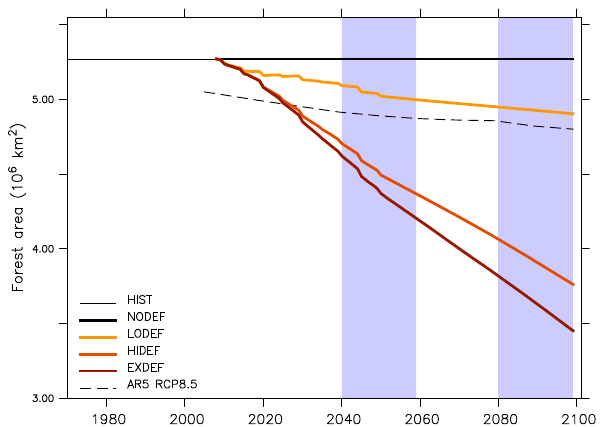
Figure 5. Interannual variation of forest area (10 6 km 2 ) over the Amazon Basin, according to the NODEF scenario, the three LCC scenarios and the SSP of the AR5 RCP8.5 scenario over 2009– 2099. The blue bands indicate the two future periods selected for this study.